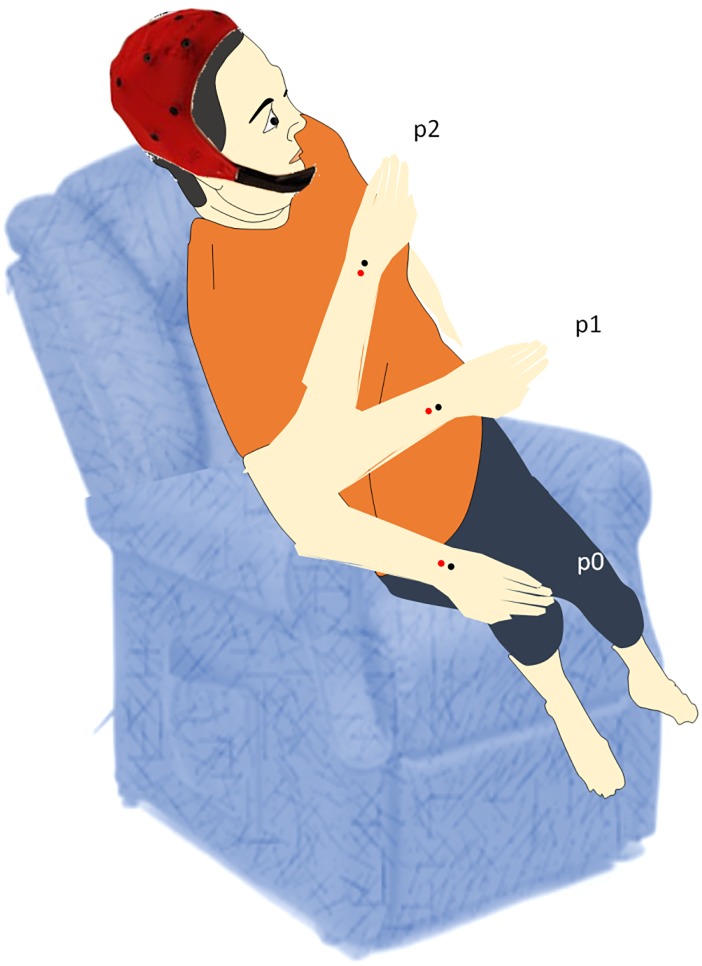
Experimental design.